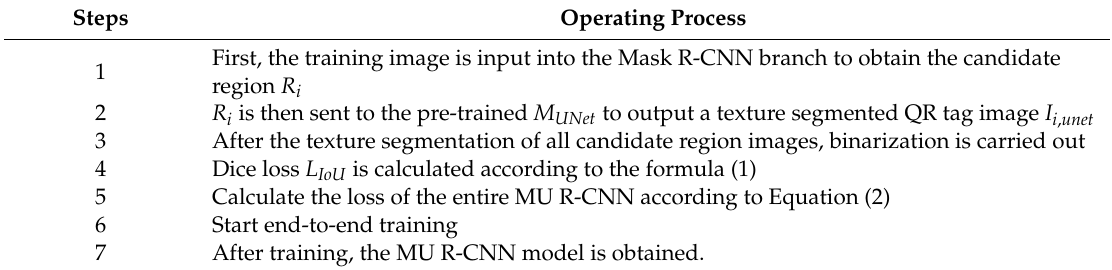
Table 2. Training process of total MU